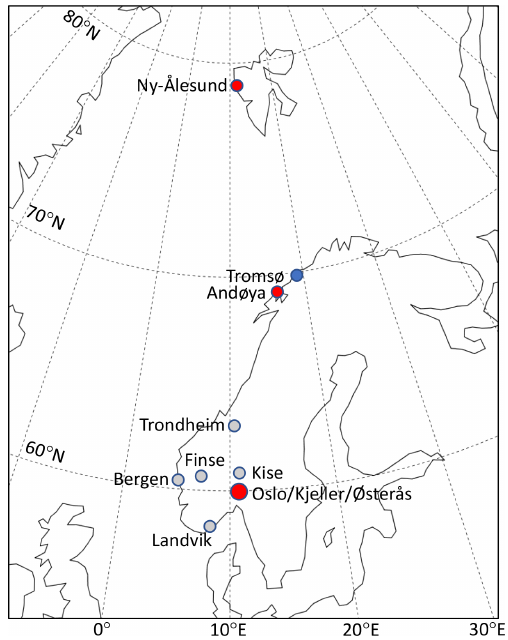
Figure 1. The Norwegian UV network. Grey circles represent sta- tions operated by DSA, whereas red circles represent sites operated by NILU. The large red circle to the south includes the three stations at Østerås (DSA), Blindern, in Oslo, and Kjeller. The instrument in Tromsø (blue circle) was moved to Andøya in